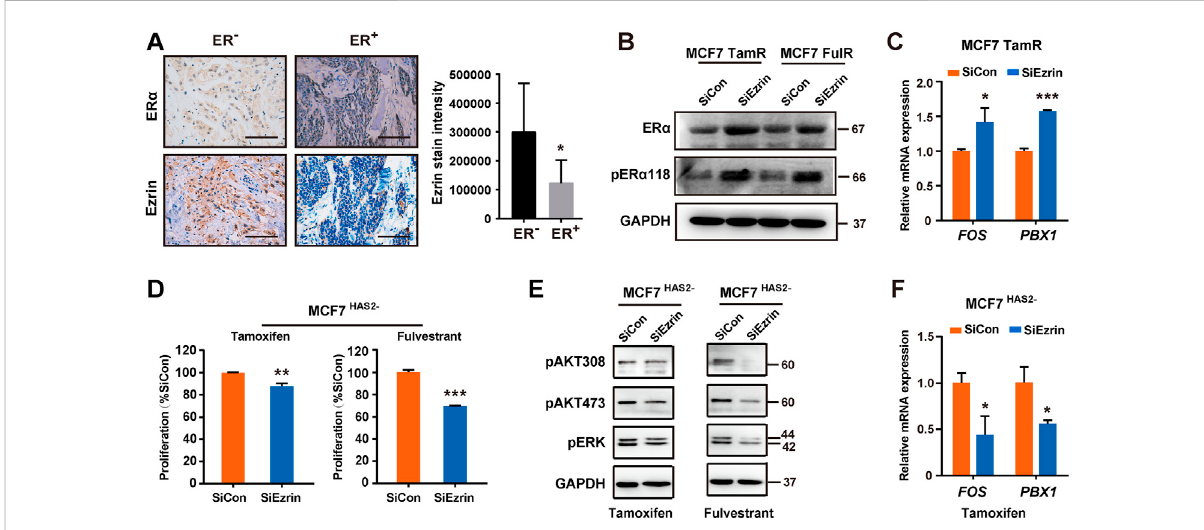
FIGURE 4 HAS2-Ezrin-ER axis regulated antiestrogen sensitivity. (A) The levels of ER and Ezrin in human breast cancer tissues were evaluated by immunohistochemistry.Signi fi cant(* p < 0.05,Mann-Whitneytest)decreaseofEzrinstainingwasobservedinpatientswithER + breastcancer( n =12) compared with ER − patients ( n = 6). (B) Knockdown of Ezrin promoted ER expression and activation in resistant MCF7 cells. (C) The effects of Ezrin knockdownon the mRNA levels of FOS and PBX1 in MCF7 TamR cells were determined by real-time PCR. (D) MCF7 HAS2- cells were transfected withsiEzrinorcontrolsiRNAs,andexposedto1 μ Moftamoxifenorfulvestrantfor3 days.Then,theproliferationofcellswasdetectedusingaCCK-8 assay. (E) The AKT and MAPK signaling pathways were analyzed in MCF7 HAS2- cells transfected with siEzrin or control siRNAs in the presence of 1 μ M antiestrogens for 3 days. (F) MCF7 HAS2- cells were transfected with siEzrin or control siRNAs, and treated with tamoxifen or fulvestrant (1 μ M) for 3 days. Then, the mRNA levels of FOX and PBX1 were evaluated. Statistical analysis: t -test. Values were presented as the mean ± SD. * p < 0.05, ** p < 0.01, *** p < 0.001.